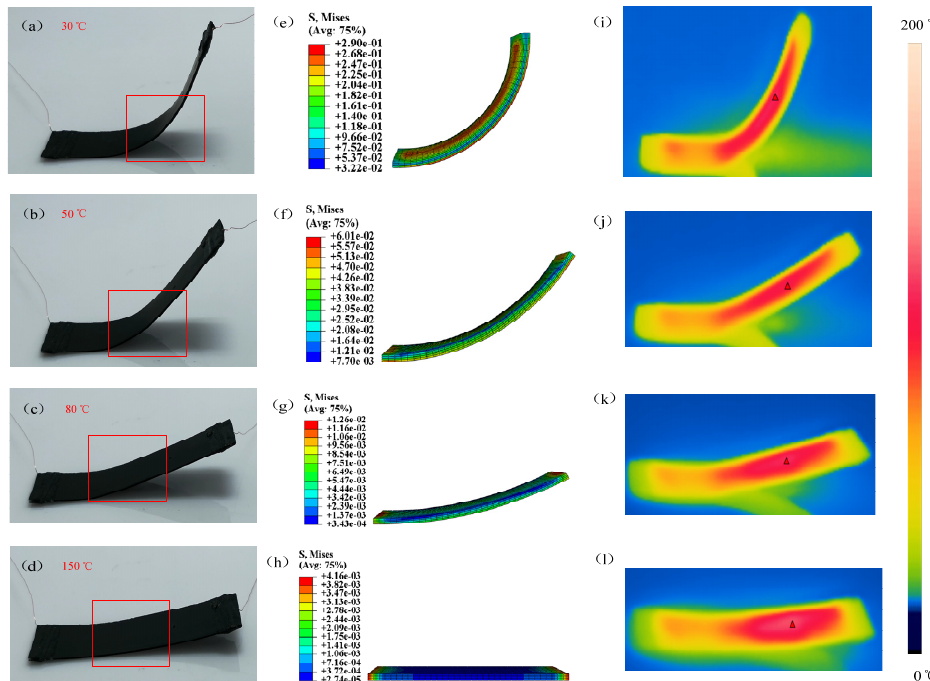
Figure 21. Simulation analysis chart and temperature field diagram for E-SMP during recovery: ( a – d ) deformation of the S-DS at 30, 50, 80, and 150 ◦ C; ( e – h ) simulated stress cloud diagram of the S-DS at 30, 50, 80, and 150 ◦ C; ( i – l ) experimental temperature test at 30, 50, 80, and 150 ◦